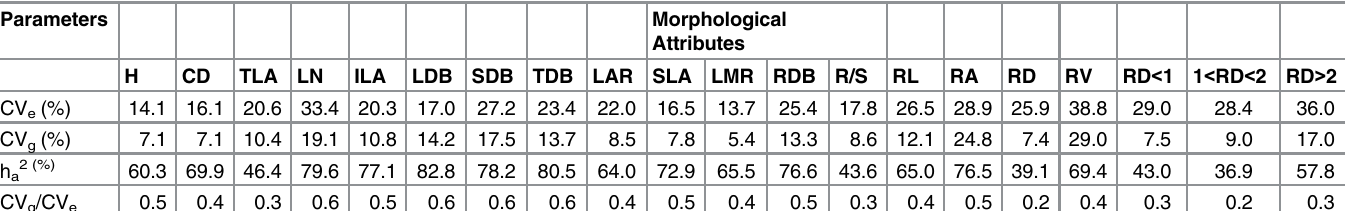
(CV e ), experimental variation coef fi cient; (CV g ), genetic variation coef fi cient and (h a2 ) heritability H, high; CD stem diameter; TLA, total leaf area; NL, leaves number; ILA, individual leaf area; LDB, leaf dry biomass; SDB, stem dry biomass; TDB, total dry biomass; LAR, leaf area ratio; SLA, speci fi c leaf area;